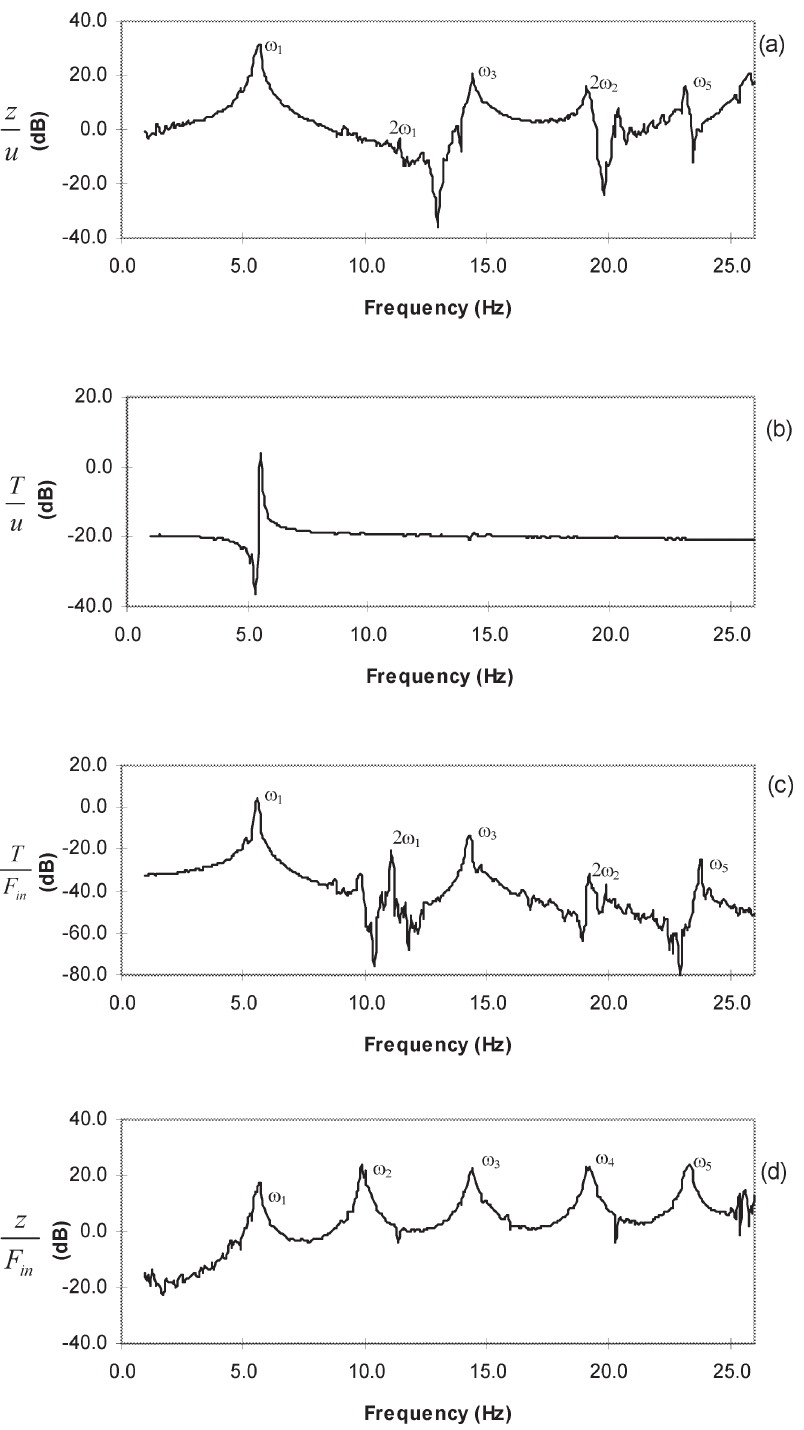
Fig. 9. Frequency response function between: (a) the active tendon displacement u and the amplitude z of the in-plane vibration; (b) the active tendon displacement u and the tension T in the cable; (c) the shaker force F in and the tension T in the cable; (d) the shaker force F in and the amplitude z of the in-plane vibration of the